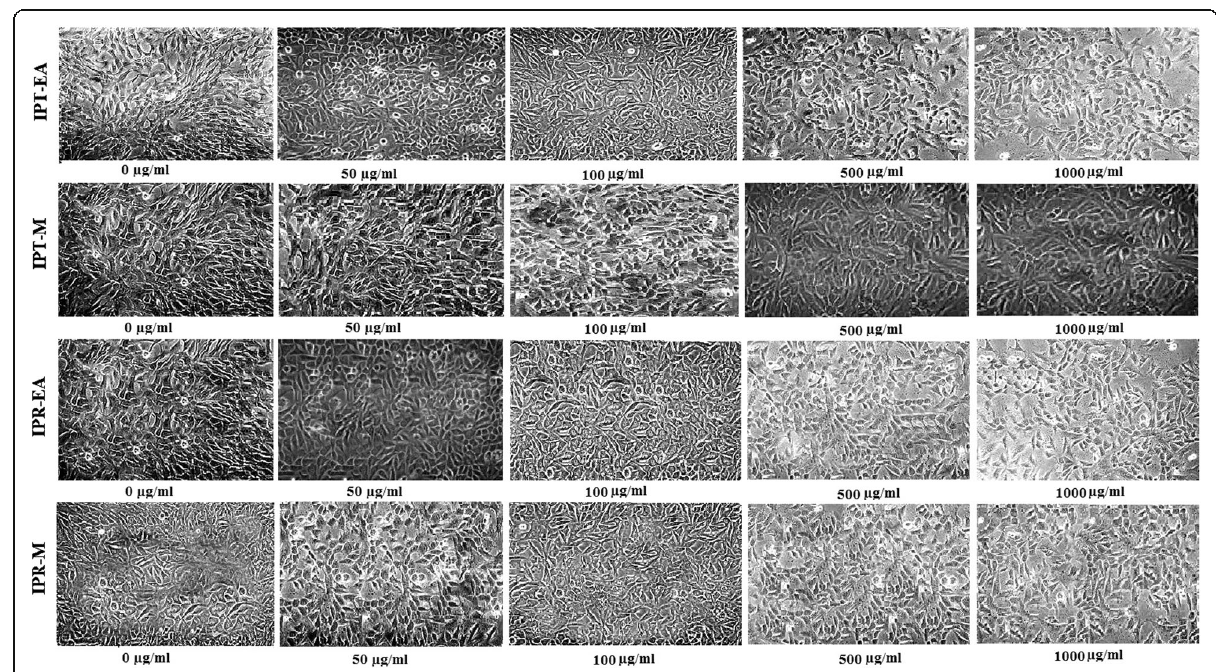
Fig. 2 Effect of Ipomoea batatas on the cell viability of rabbit articular chondrocytes. Microscopic images of cells untreated or treated with indicated concentration of IPT-EA, IPT-M, IPR-EA and IPR-M. Results are mean ± SD of triplicate